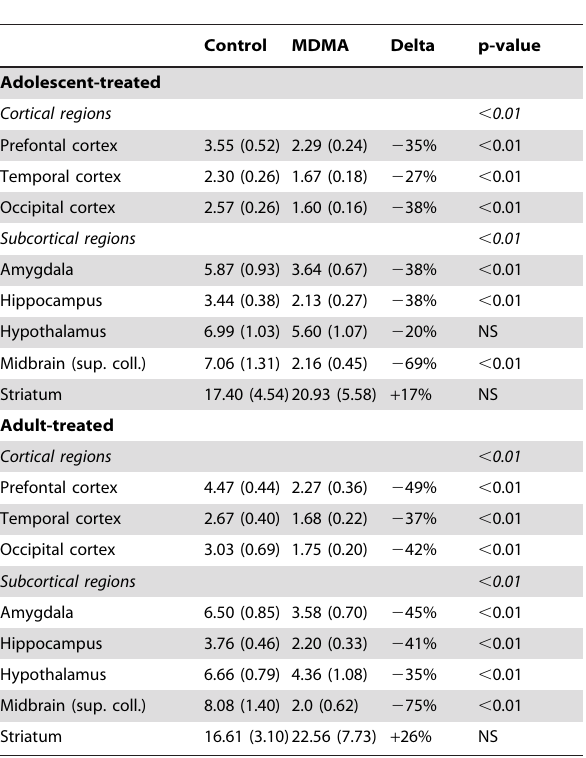
Table 2. Specific [ 123 I] b -CIT SERT binding ratios in saline and MDMA-treated